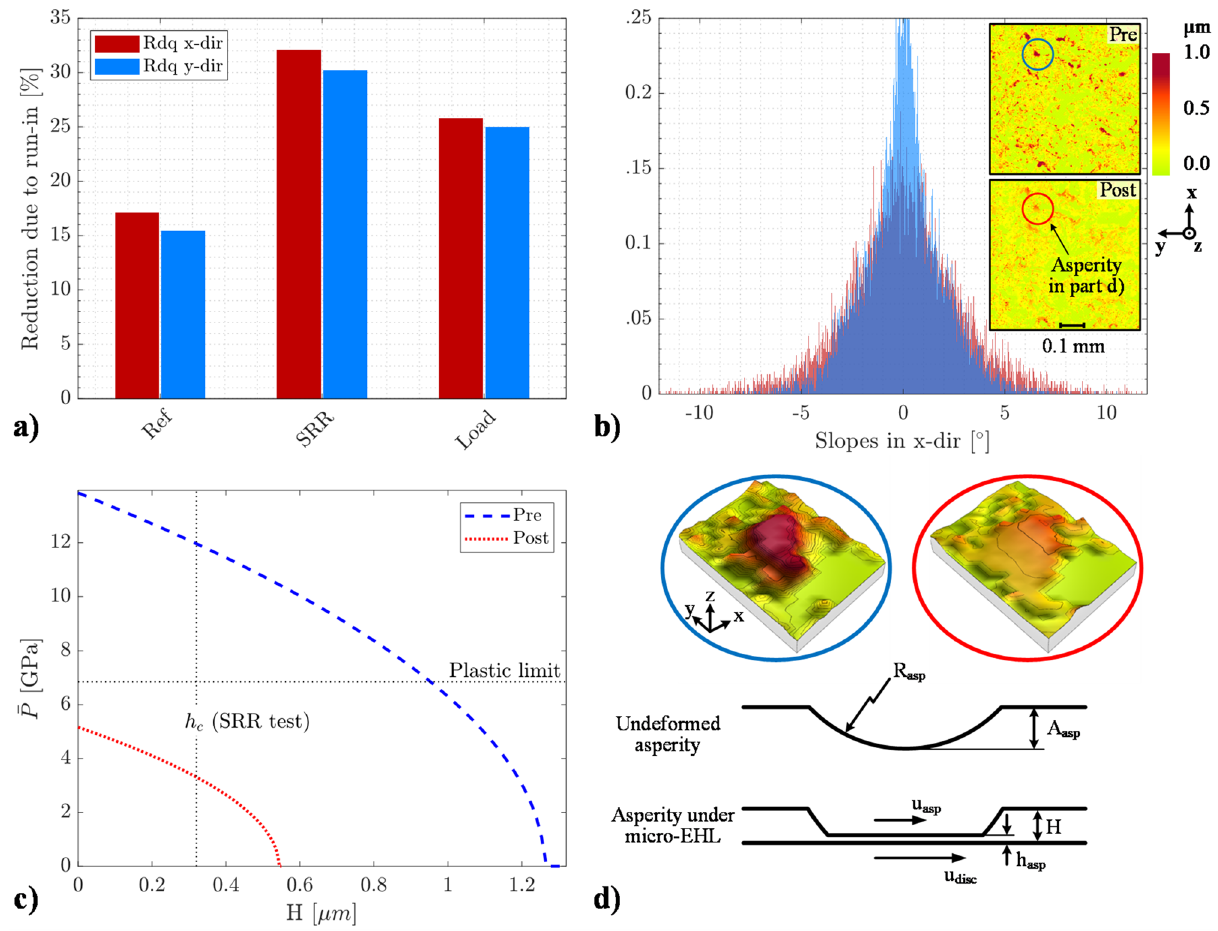
Figure 6. a ) The Rdq distribution in both the x- (sliding) and y-directions, ( b ) the surface pair after extraction of the 65% highest peaks together with the histogram of slopes in the x-direction, ( c ) the solution to the proposed micro-EHL model, i.e., the mean hydrodynamic pressure acting on the idealised version of the pre- and post-test asperity shown in ( d ), and additionally in ( d) , schematic including the essential features of the micro-EHL